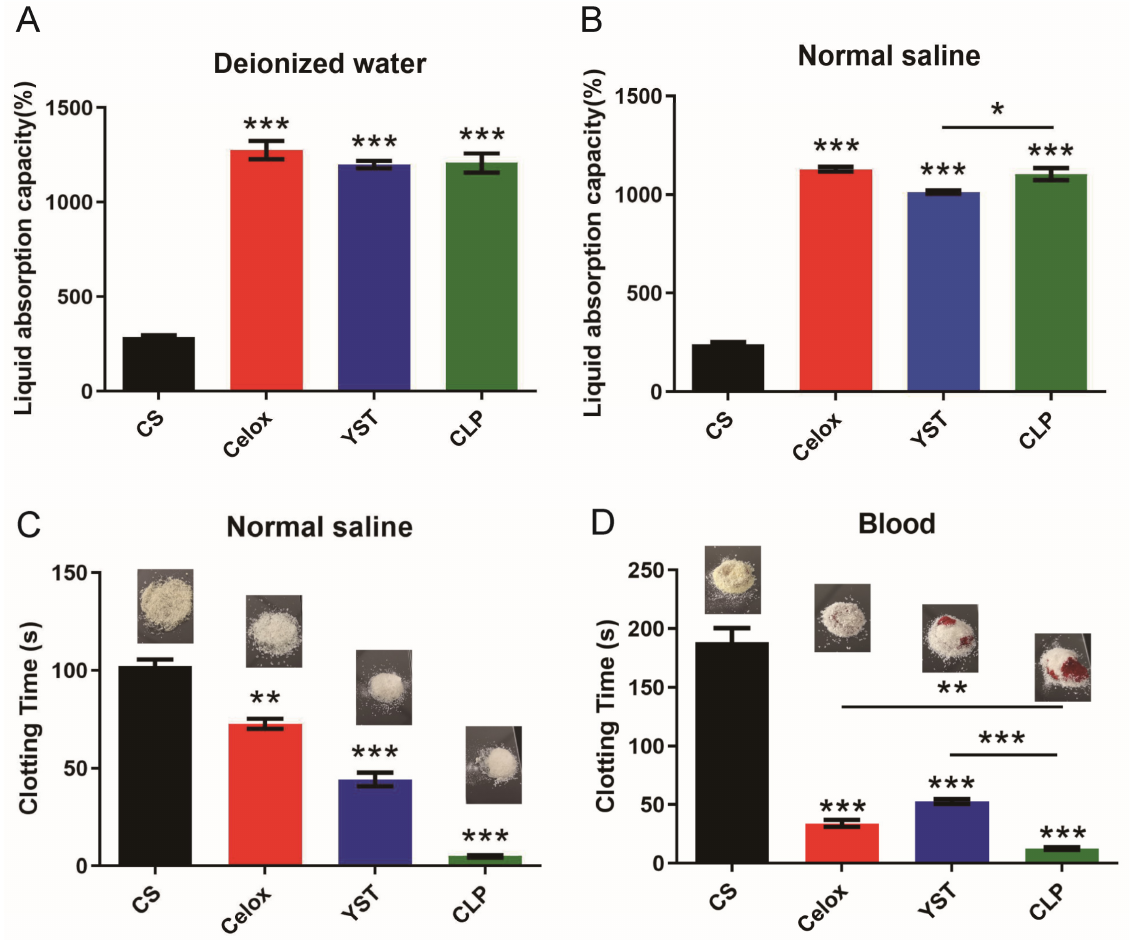
Figure 3. The capacity of liquid/blood absorption. ( A ) Deionized water and ( B ) Normal saline ( n = 3). The clotting time of hemostatic particles on ( C ) Normal saline and ( D ) blood, as well as visual images ( n = 3). Values represent means ± SEM. The differences between each group were performed using a two-tailed unpaired t -test. The ‘NS’ indicated no significant difference, * p < 0.05, ** p < 0.01, and *** p < 0.001.